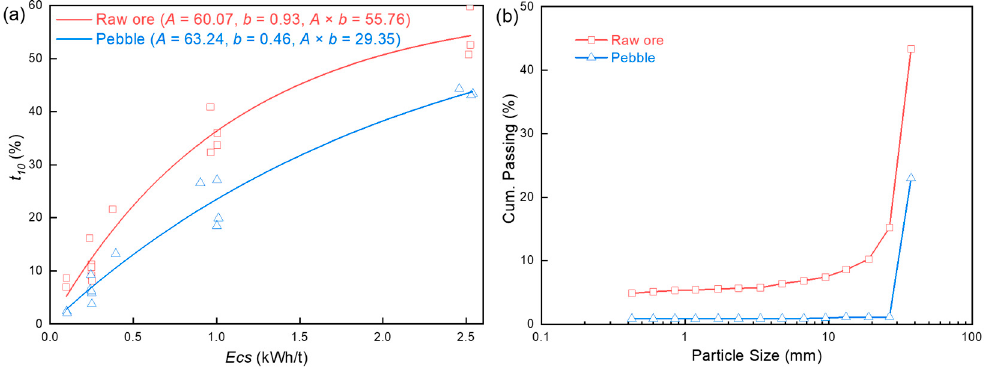
Figure 5. ( a ) Relation between E cs and t 10 ; ( b ) Particle size distribution of abrasion products